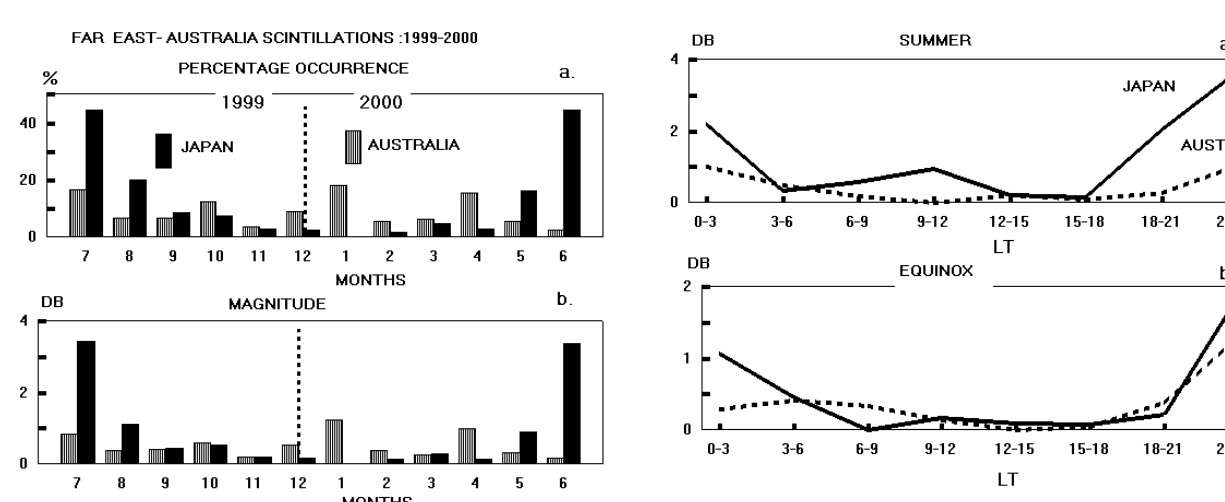
Fig. 6. Comparison of mid-latitude average diurnal scintillation levels in the Far East and Australia recorded during summer and equinox.